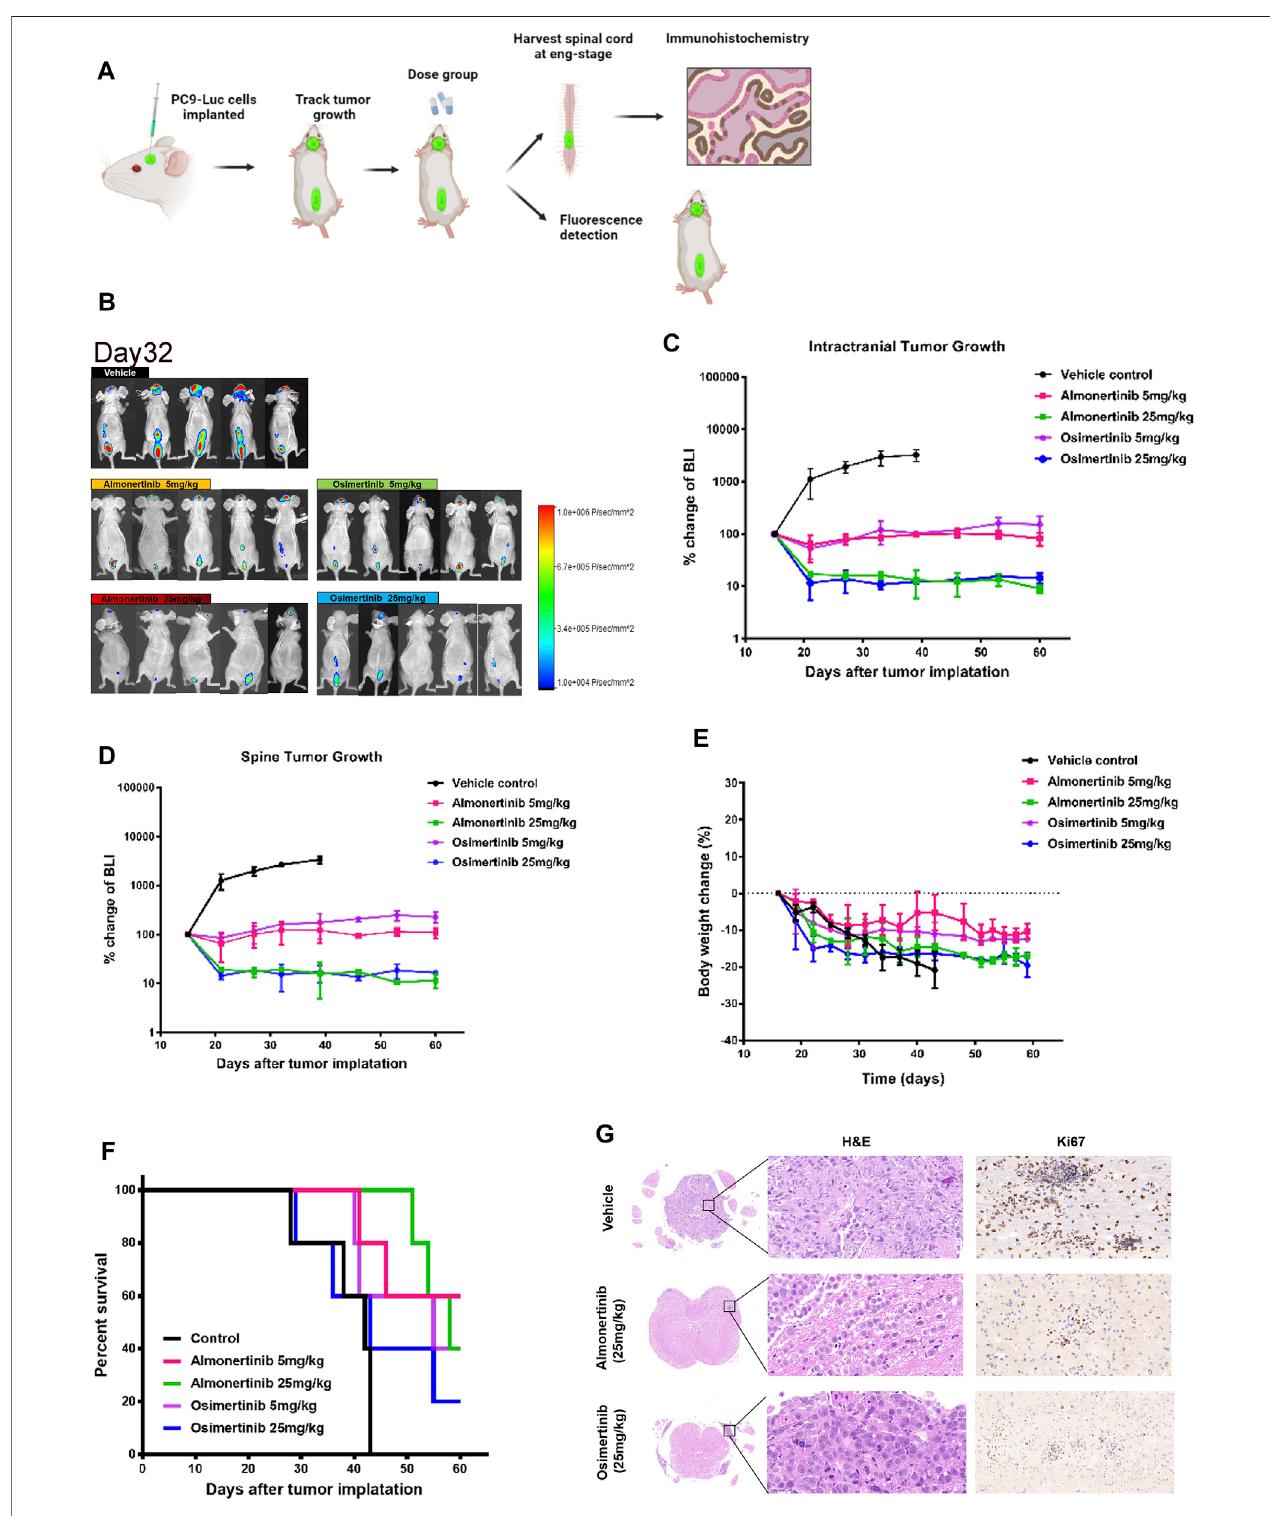
FIGURE 3 | Antitumor effect of almonertinib in PC9-LUC-injected mice with spinal cord metastases. (A) Establishment of a spinal cord metastasis model of non-small cell lungcancerwithbrainmetastasis; (B) TwoweeksaftertheinjectionofPC9-LUC,theanimalsweretreatedwithalmonertiniborosimertiniboncedaily.Almonertinib5and25 mg/kg (Qd)andosimertinib5and25 mg/kg(Qd)wereusedtotreatPC9-LUC-injectedmicewithbrainmetastasesandspinalcordmetastases.Intracranialtumorbioluminescence (C) , spinal cord tumor bioluminescence (D) , body weight (E) , and overall survival rate (F) were observed. Scale bar, 50 μ m. Data are presented as mean ± SEM ( n (cid:2) 5/group). ** p < 0.01 vs. vehicle control. (G) The expression of Ki-67 in the spinal cord tissue was detected by hematoxylin-eosin staining and immunohistochemical staining.